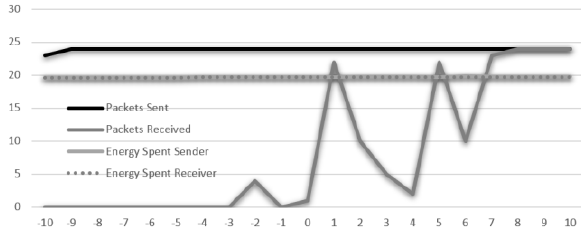
Figure 11. Remaining Energy vs Transmission Power under Scenario 1c .